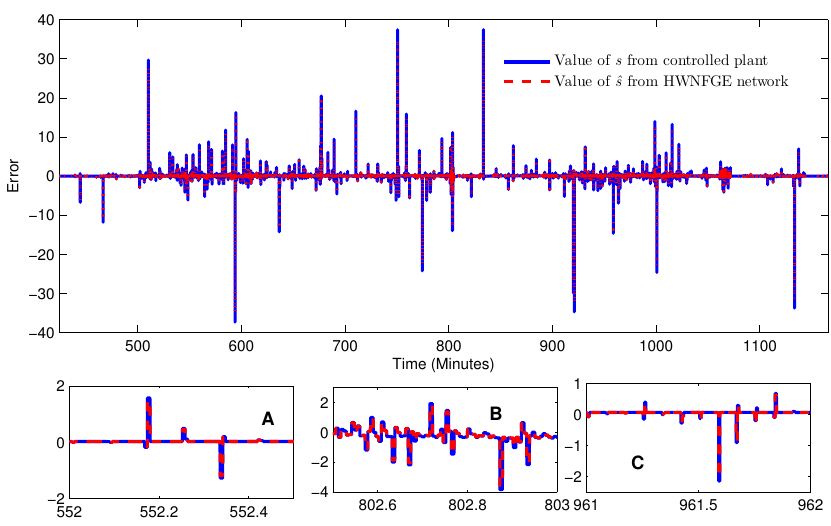
Figure 6. Comparison between experimental error s and HWNFGE generated error ˆ s ( A ) zoomed plot at t = 552–552.5 min ( B ) zoomed plot at t = 802.5–803 min; ( C ) zoomed plot at t = 961–962